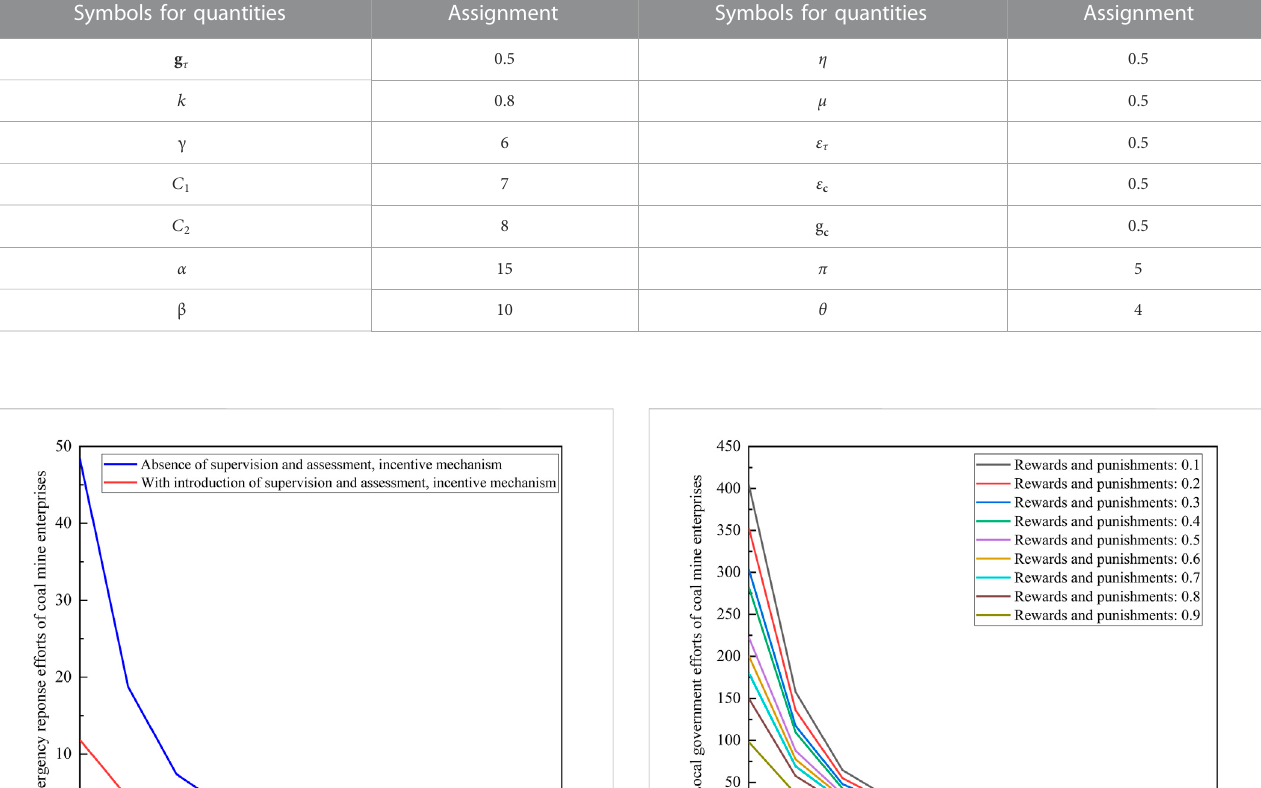
TABLE 4 Parameter assignment. Symbols for quantities